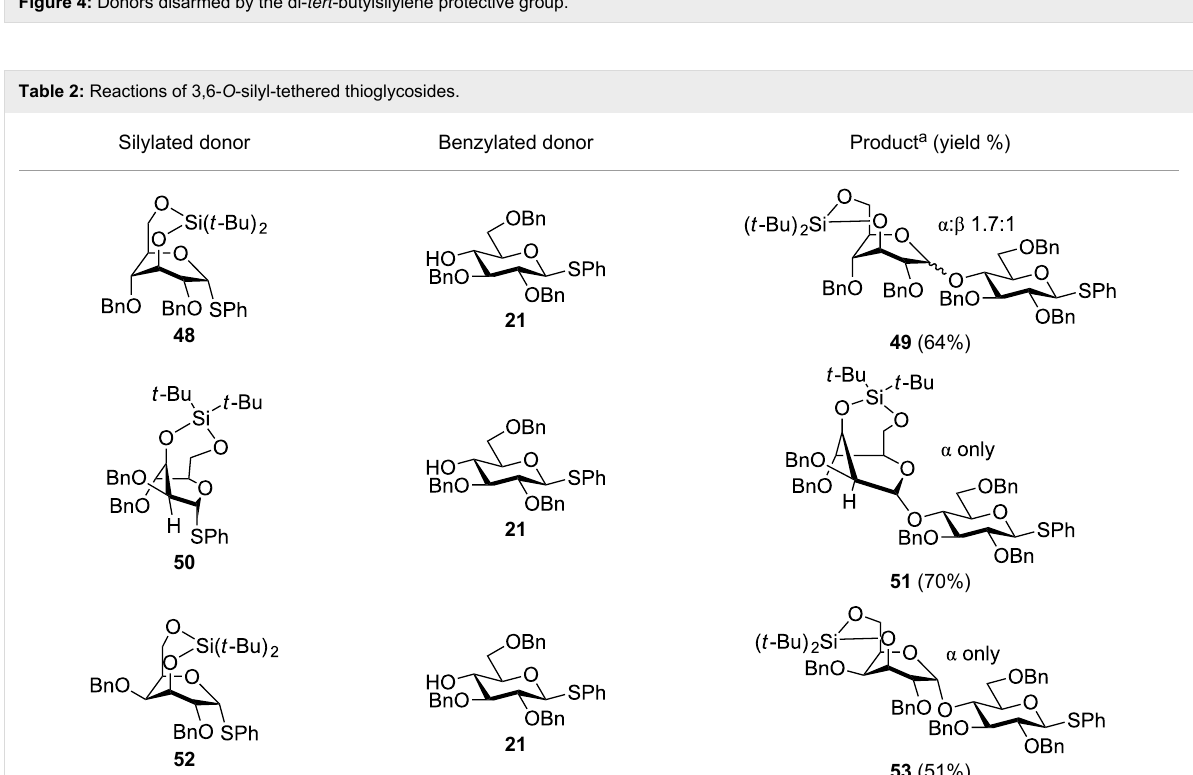
Figure 4: Donors disarmed by the di- tert -butylsilylene protective group.